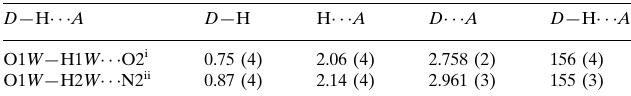
Hydrogen-bond geometry (A˚ , (cid:3)